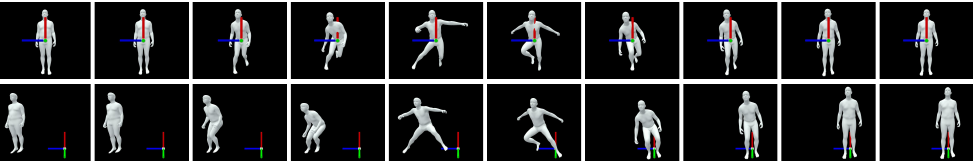
Figure 2. The top row shows the image sequence rendered using only the local pose without the global pose. Here, the relative orientations between rigid body parts (i.e., local pose) change, but the entire body’s orientation and location (i.e., global pose) remain unchanged. The bottom row shows the rendering result for the case where the global pose is further included. Please note that the main purpose of the paper is to estimate the global pose sequence from the local pose